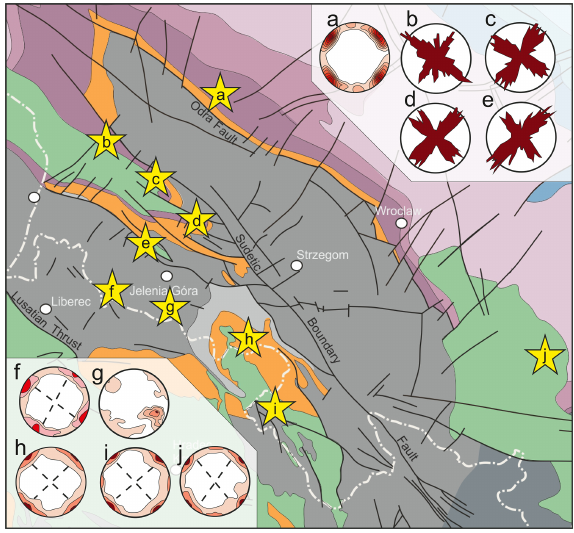
Figure 19. Comparison of stereograms and rose diagrams of the dominant steep joint sets coming from several local studies (by Jerzykiewicz et al., 1974; Aleksandrowski, 1976; Solecki, 2011; Selerowicz et al., 2014) made at various locations in the Polish Sudetes. Background: the geological map of Fig.